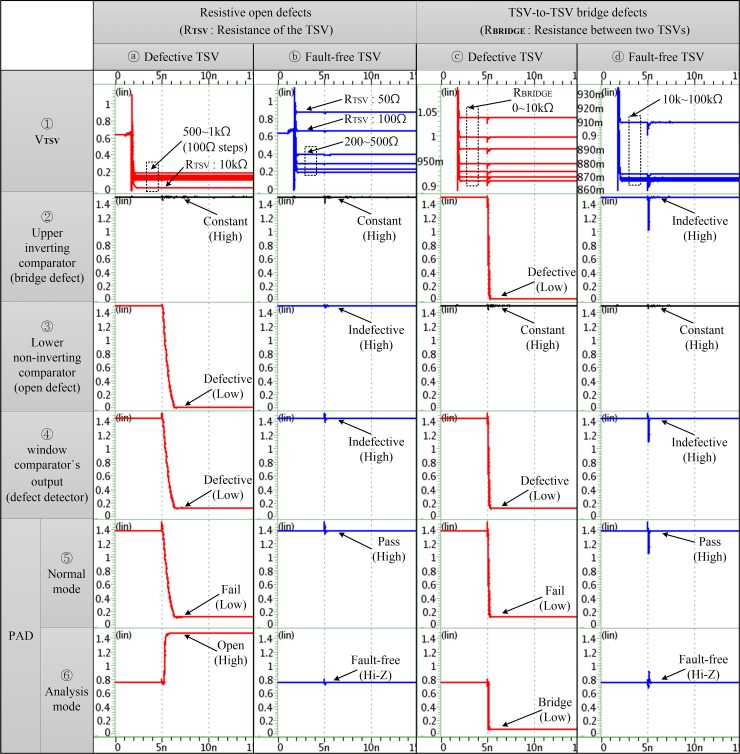
Voltage profiles as a function of RTSV and RBRIDGE changes.